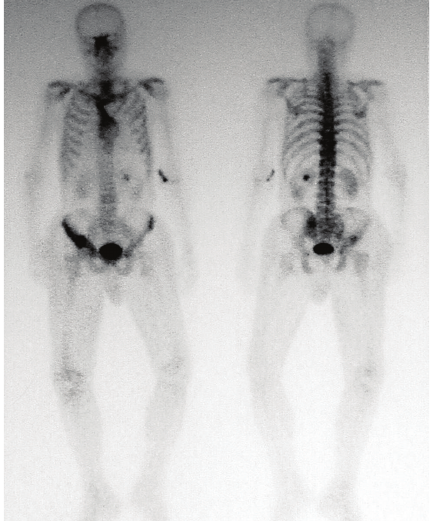
Figure2:99mTcbonescanrevealedmetastasisonrightacetabulum and sacrum.